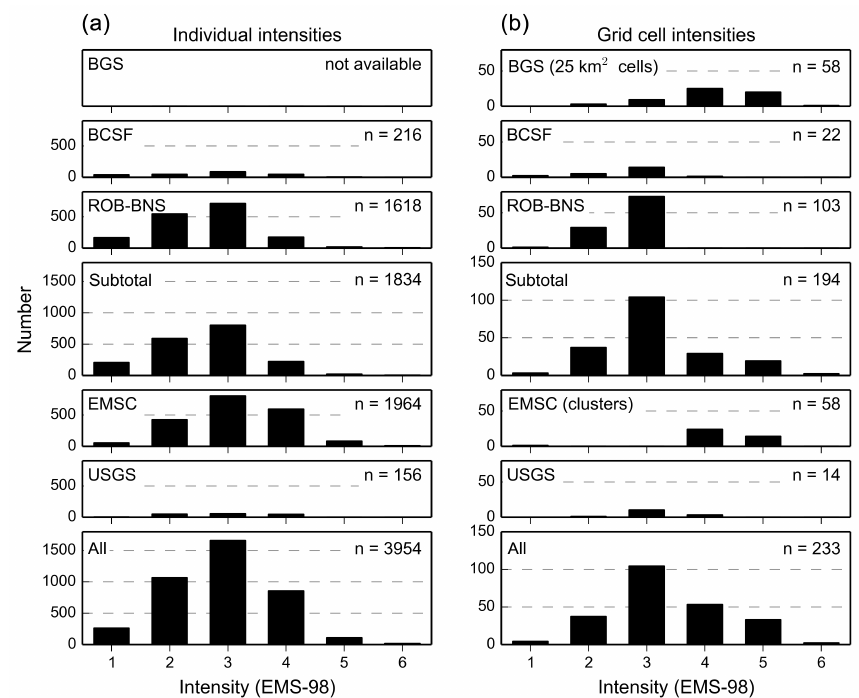
Figure 9. Ramsgate earthquake intensity distributions binned per full-intensity unit. Left: individual IDPs. Right: grid cell intensities of cells with more than two responses. BGS individual intensities were not available.